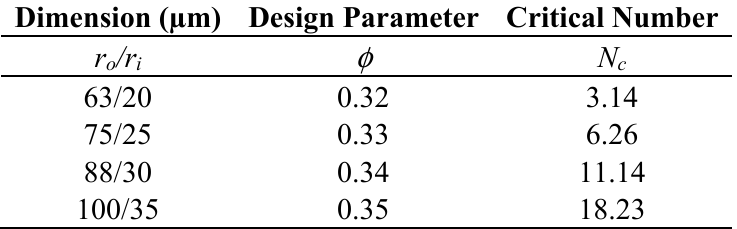
Table 1. Stiction valve radii and calculated critical number N film thickness t = 2 µm and height h v